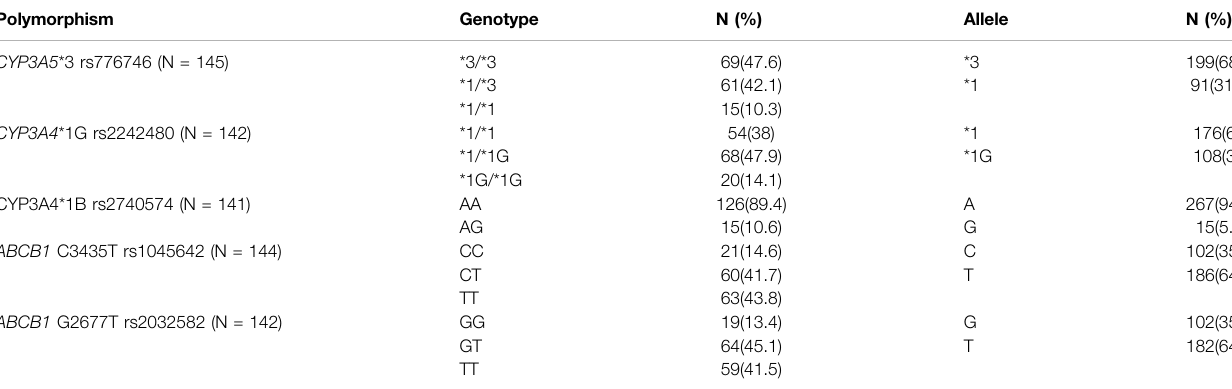
TABLE 3 | Genotype and allele frequencies of SNPs in the study population.